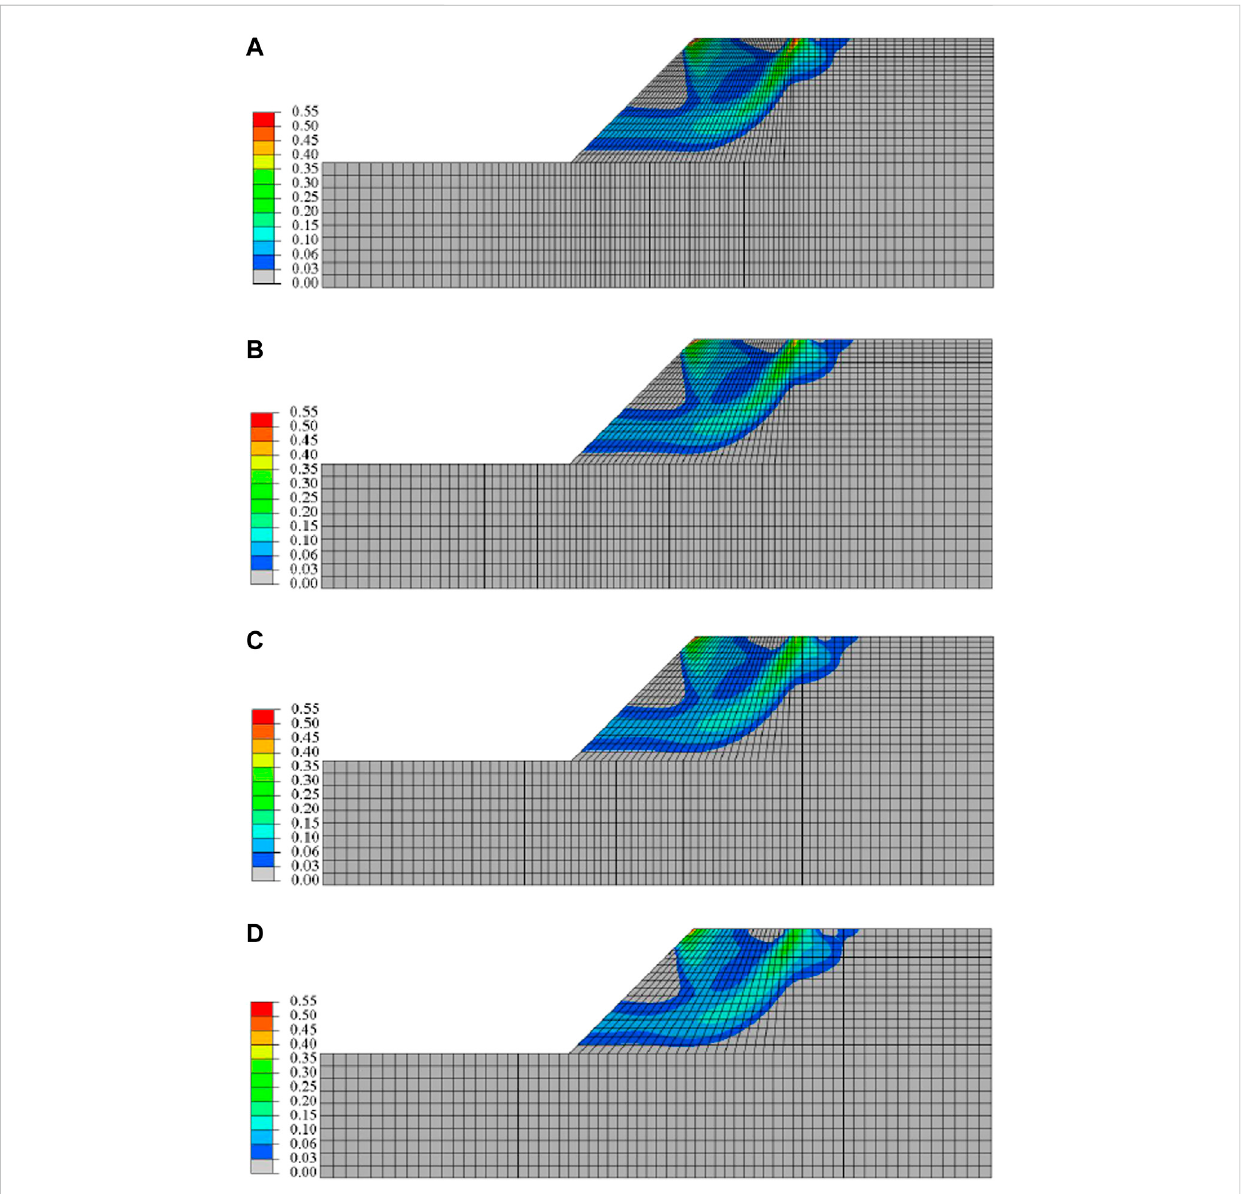
FIGURE 13 Color plot of equivalent plastic strain (in %) based on multiscale FEM ( l e = 0.1 mm). (A) Mesh 1, (B) Mesh 2, (C) Mesh 3, and (D) Mesh 4.